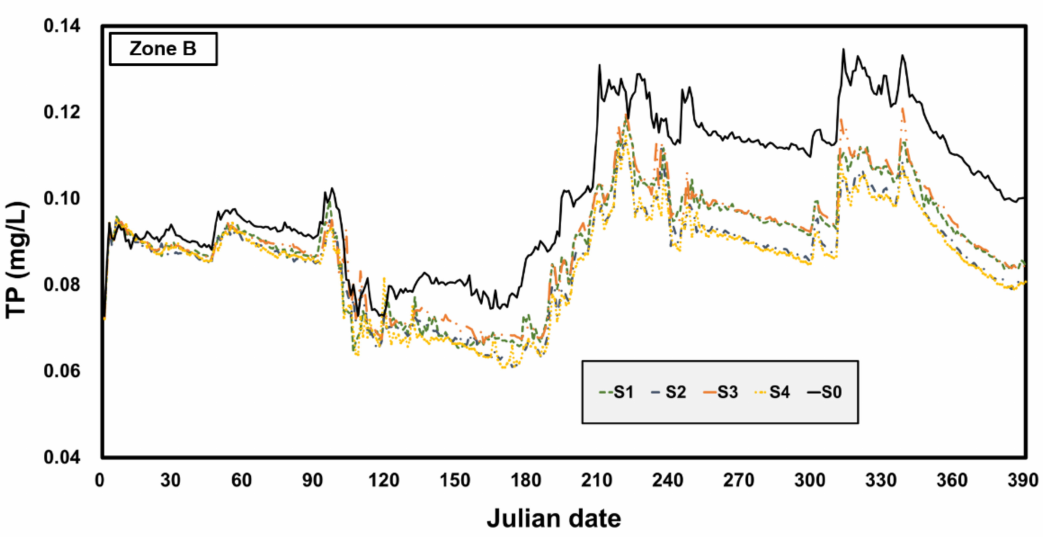
Figure 11. Simulated results of T-P concentration (Zone B, S0,